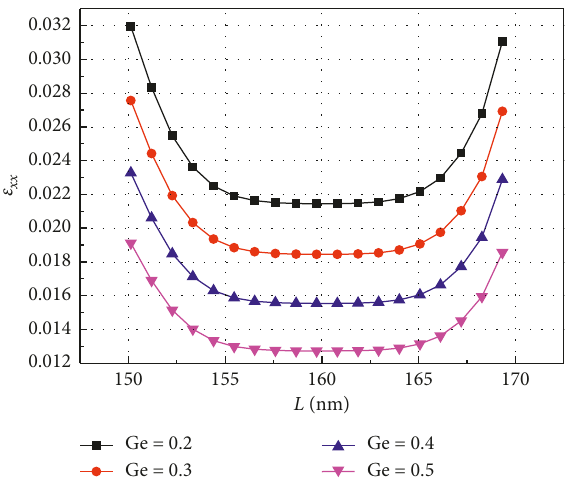
Figure 12: Magnitude regularity of ε xx at 5nm depth when the Ge component is 0.2, 0.3, 0.4, and 0.5.